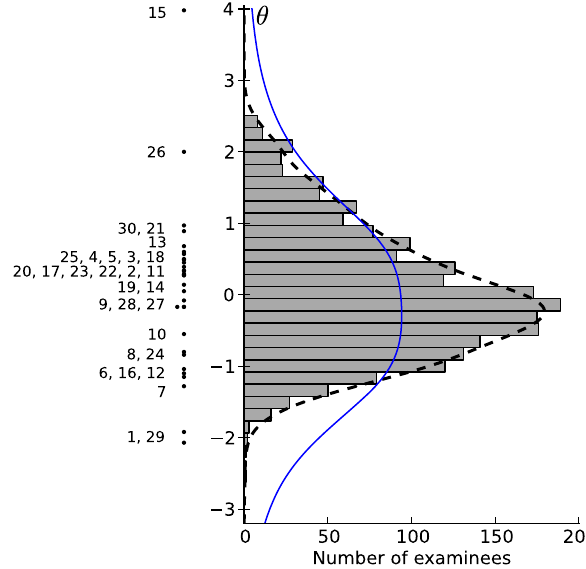
FIG. 4 (color online). The histogram of the students ’ profi- ciency scores (right) with the individual item difficulties (left) for the single-trait model. On the right-hand side the smoothed distribution of the skill (bold dashed line) and the test information curve (solid line) have also been depicted.